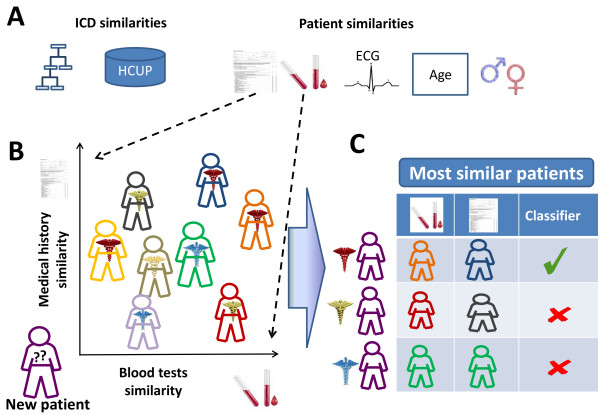
A schematic view of the method. Similarities between ICD codes and between hospitalizations are computed (A). A new patient is scored according to the most similar patients with a certain diagnosis (B). A classifier is applied to select the top scoring diagnoses for this patient (C). ICD, International Classification of Diseases.